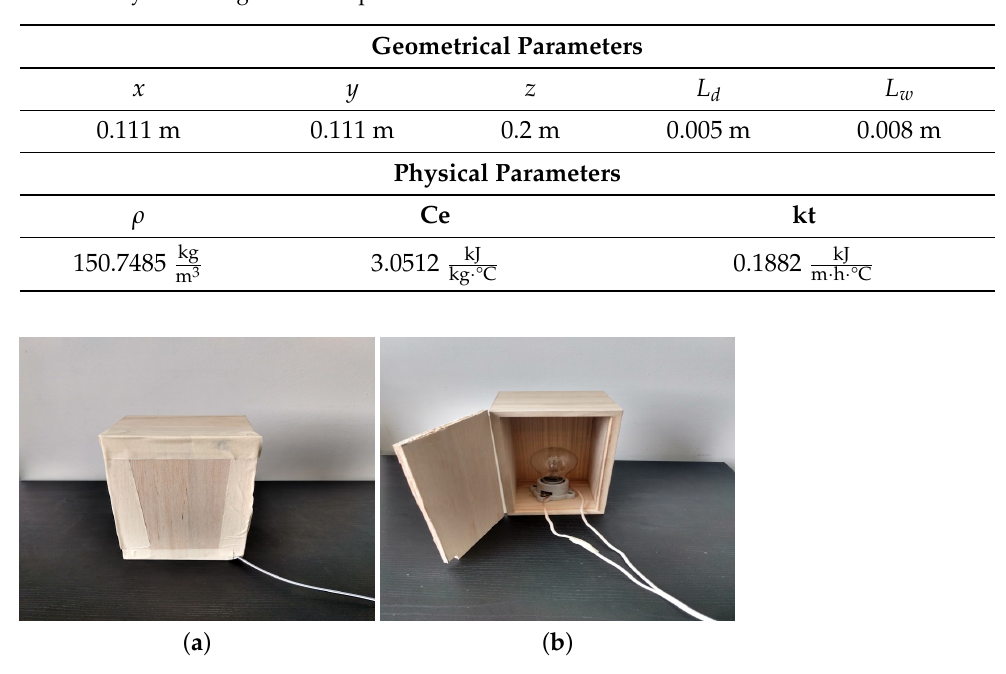
Table 1. Physical and geometrical parameters.